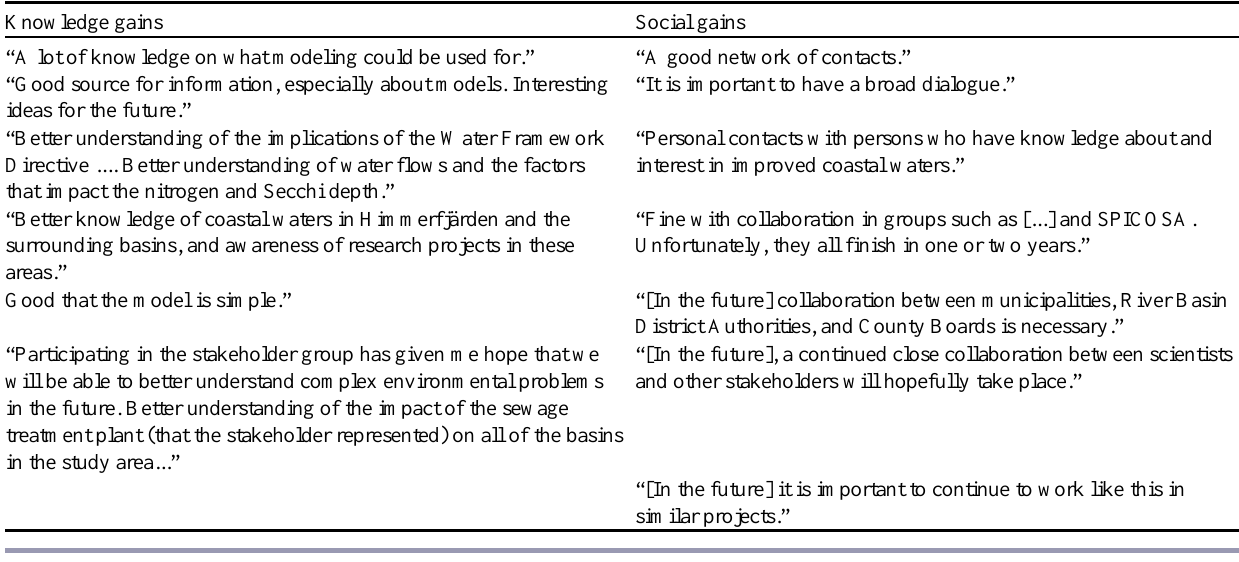
Table 5 . Examples of stakeholder views regarding participation in SPICOSA. The quotations are translated answers to questionnaire 2; they are in random order and do not correlate across rows. Knowledge gains Social gains “A good network of